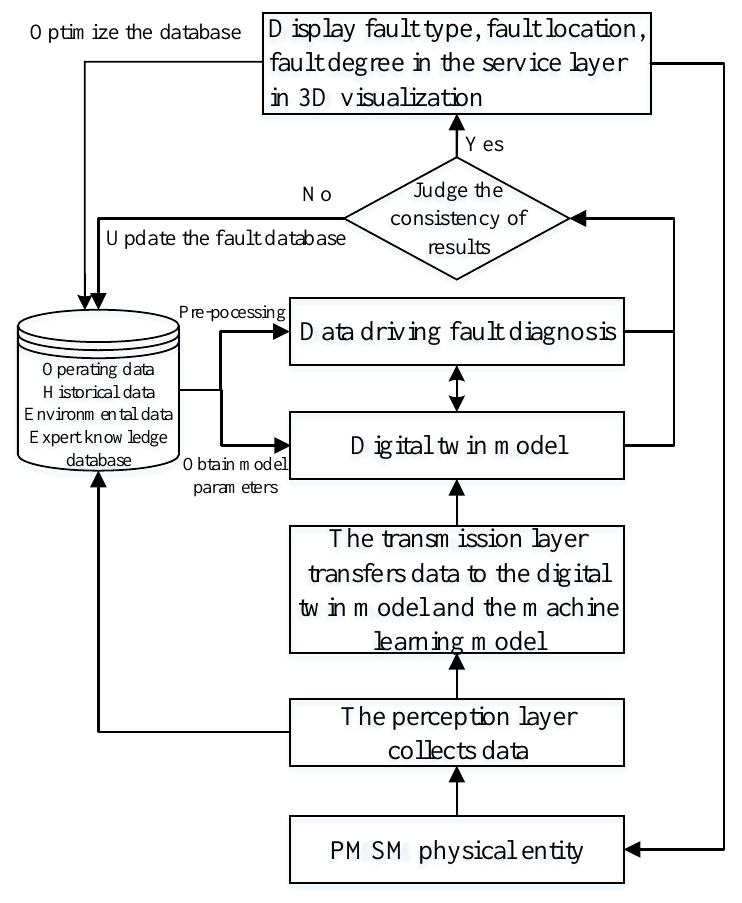
Figure 5. PMSM fault diagnosis frame.